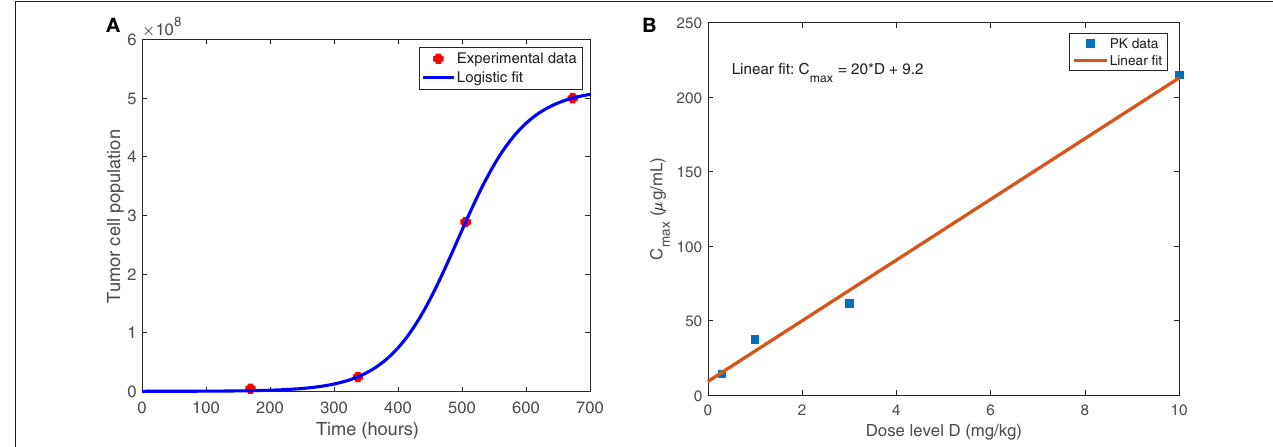
FIGURE 2 | (A) Shows the logistic growth fit to murine GBM size data in the absence of treatment, from Linsenmann et al. (2019). We use this to determine the net growth rate, r t = 0.0192 h − 1 , and carrying capacity, C T = 5.157 × 10 8 cells. (B) Displays the linear relationship between the administered dose (mg/kg) of nivolumab and the maximum plasma concentration, C max ( µ g/mL). Data is obtained from Brahmer et al. (2010).